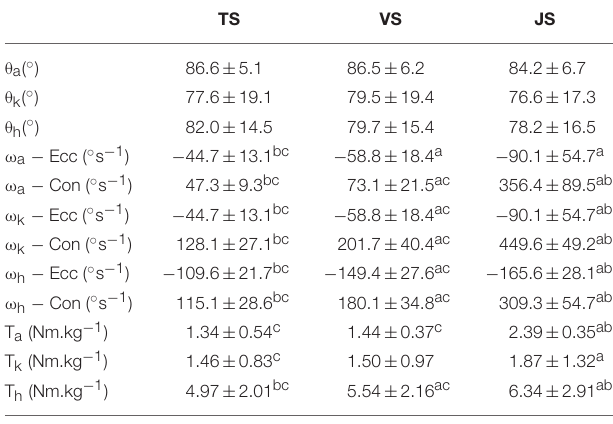
TABLE 1 | Joint kinetics and kinematics during slow-tempo (TS), volitional speed (VS), and jump (JS) squats performed with 60% of 1RM ( n =